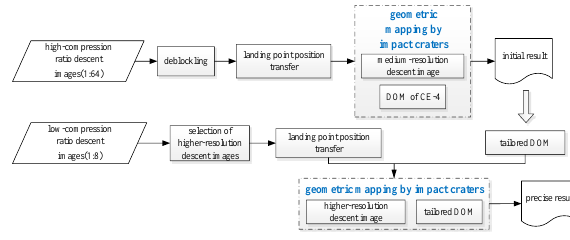
Figure 2. Flowchart of CE-4 landing point positioning